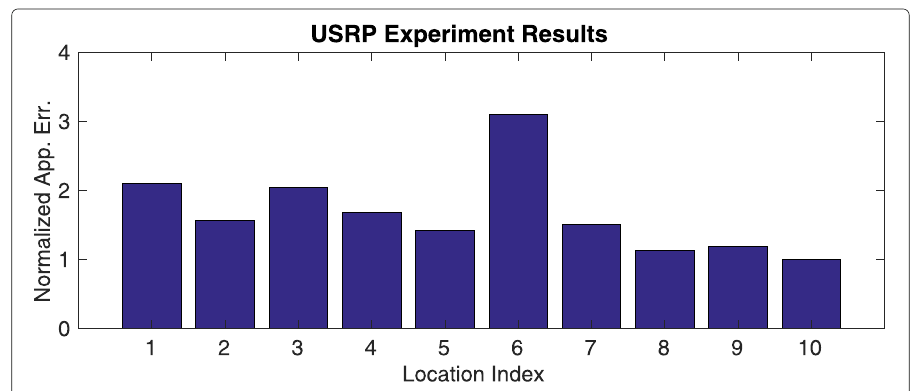
Fig. 7 Normalized approximation error in all